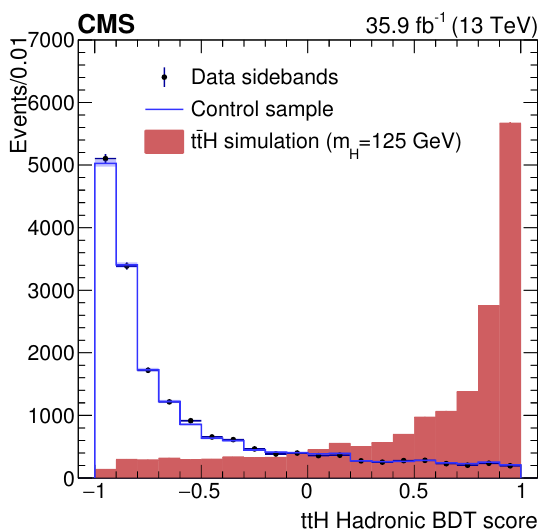
Figure 6 . Score distribution of the jet multivariate discriminant used to enhance jet tagging in the ttH multijet category. The points show the distribution for data in the signal region sidebands, m (cid:13)(cid:13) < 115 GeV or m (cid:13)(cid:13) > 135 GeV; the histogram shows the distribution for events in the data control sample; the (cid:12)lled histogram shows the distribution for simulated signal events. The distri- butions in the simulated and control samples are scaled as to match the integral of that from the data